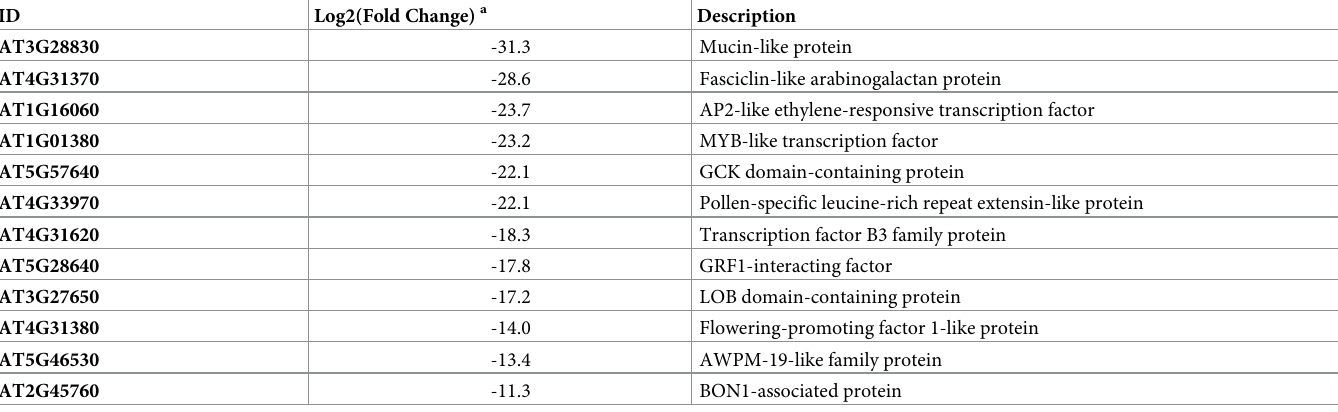
In the current study, we elucidated the mechanism through which B . aryabhattai promotes the growth of Arabidopsis and N . tabacum plants. N . tabacum plants were included to evaluate